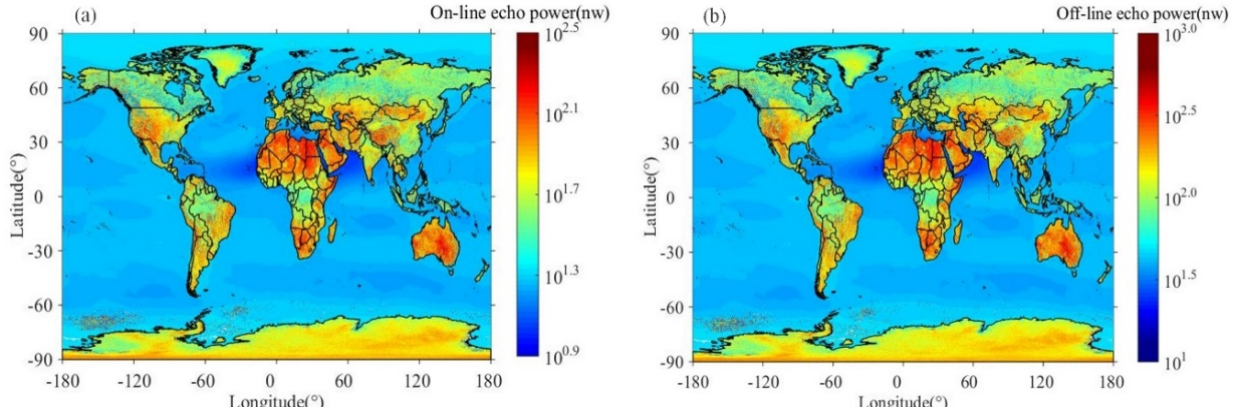
Figure 4. ( a ) Global online echo power. ( b ) Global offline echo power.